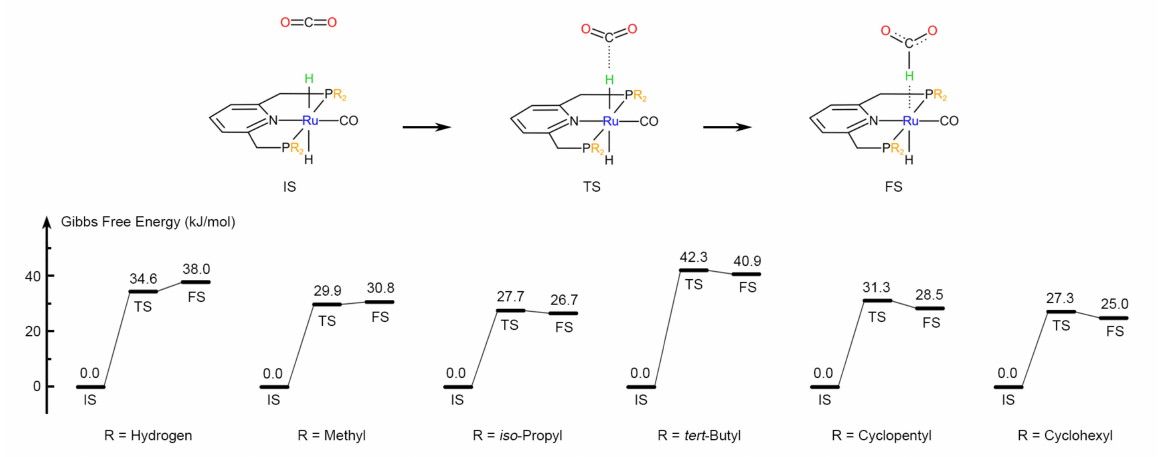
Figure 2. Free energy profile for hydride addition to CO 2 on six Ru–PNP complexes with different